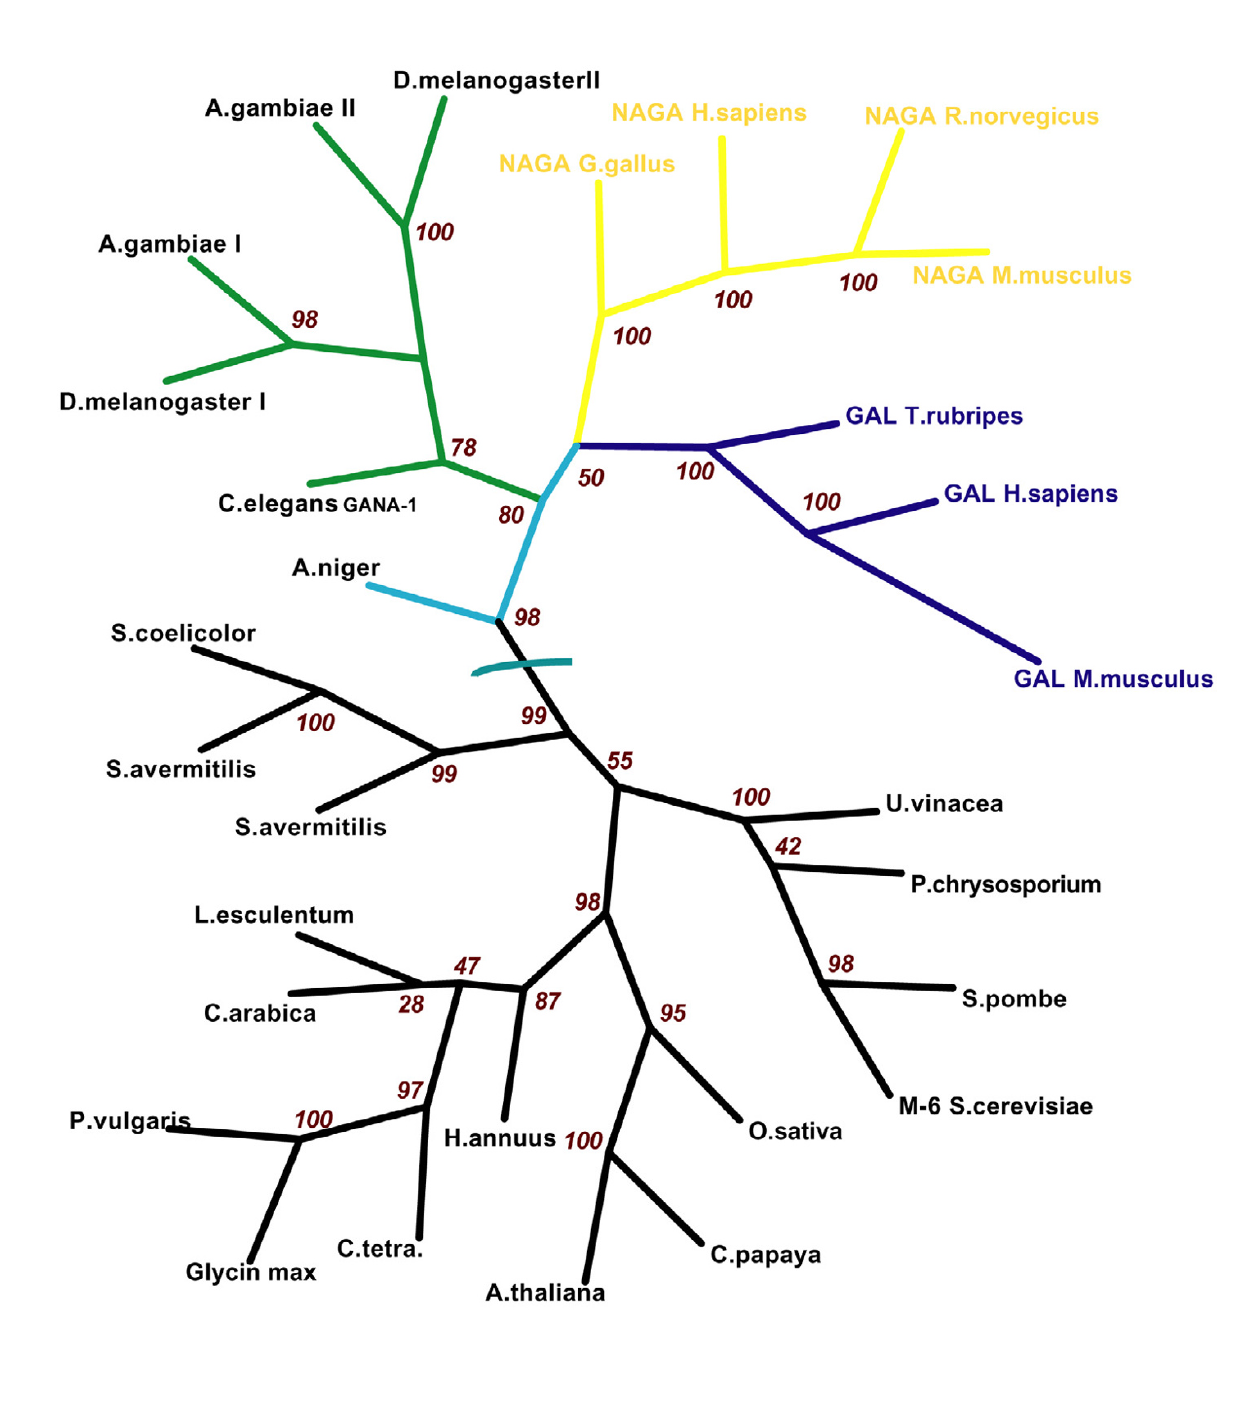
Figure 3 Cladogram of GANA-1 orthologs. The numbers at the branch nodes represent boot- strap